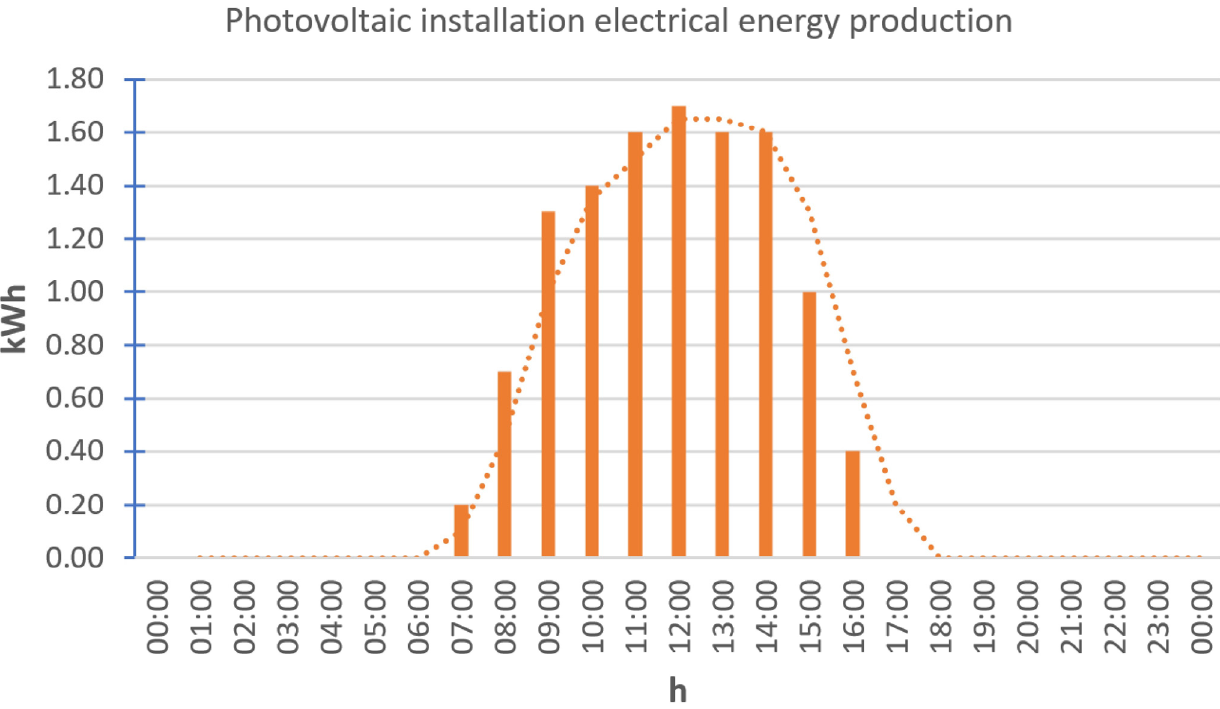
Figure 7. The 10-kW photovoltaic installation’s electrical energy production profile during a 24 h cycle. Own study based on source [55].